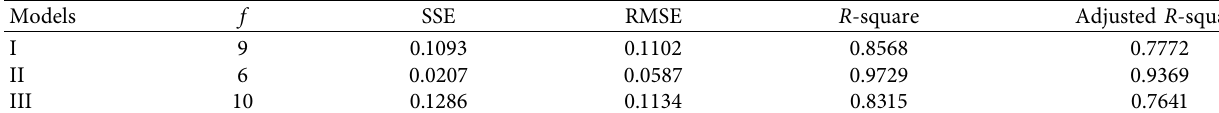
Figure 6: Three fitting surfaces. (a) Fitting surface of model I. (b) Fitting surface of model II. (c) Fitting surface of model III. Table 6: Statistical parameters of different models.